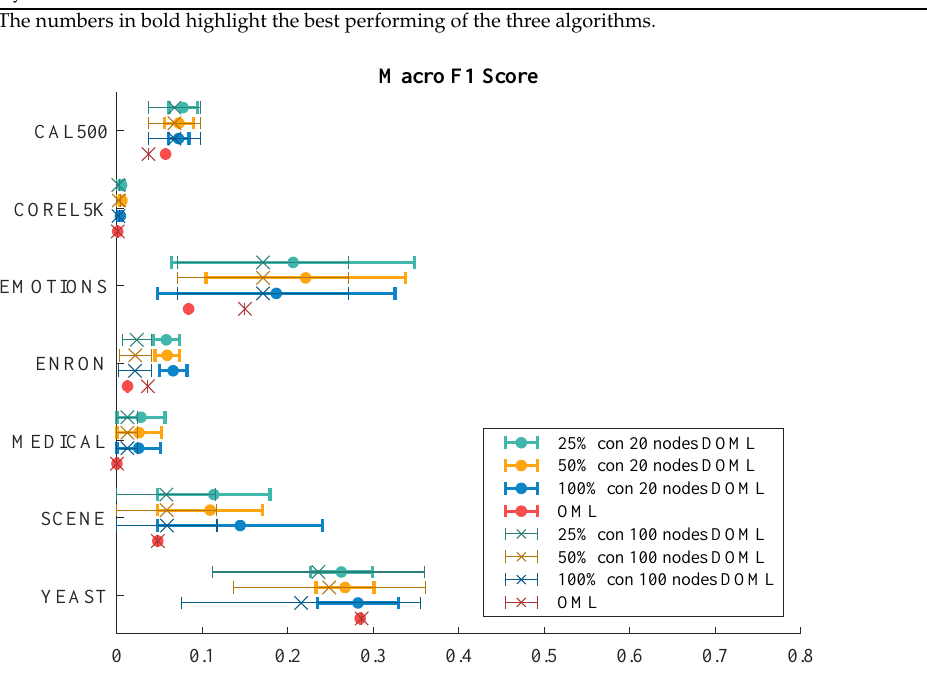
Figure 6. Macro F1 Score of DOML in a 100-node network with different connectivity and OML with same amount of instances as each